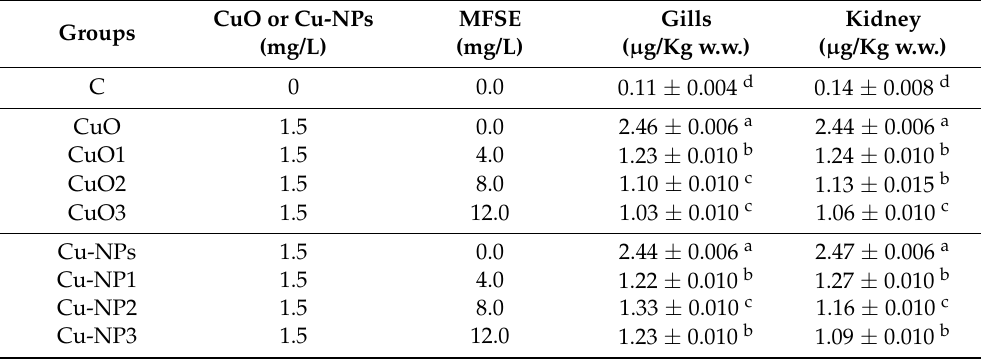
Table 4. Concentration (mean ± SE) of Cu ( µ g/Kg w.w.) in gills and kidney of the common carp C. carpio experimentally treated with 1.5 mg/L of CuO or Cu-NPs alone, and with different doses of MSFE, besides the control group (C). Means with different superscripts (a, b, c, d) presented significant differences.